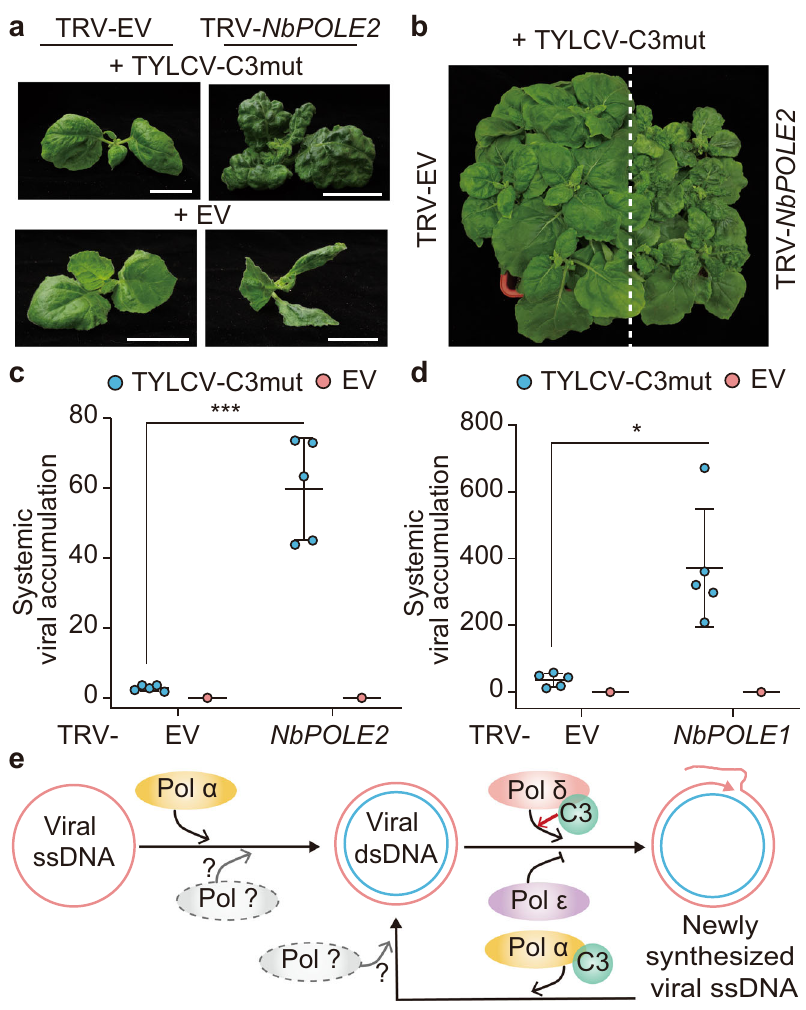
Fig. 4 Silencing subunits of DNA polymerase ε enables systemic infection of a C3 null mutant geminivirus. a , b Symptoms of POLE2 -silenced (TRV- NbPOLE2, right) or control (TRV-EV, left) N. benthamiana plants inoculated with a C3 null mutant TYLCV at 4 weeks post inoculation. EV: empty